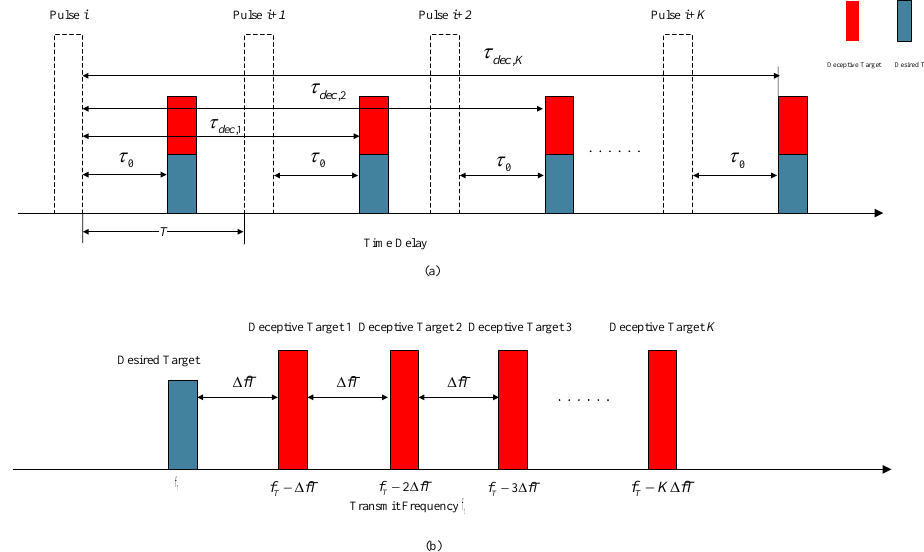
Figure 1. Illustration of range ambiguous deceptive targets in FDA-MIMO radar. ( a ) Range ambigu- ous deceptive targets in the time domain, ( b ) the desired target and deceptive targets in the transmit frequency